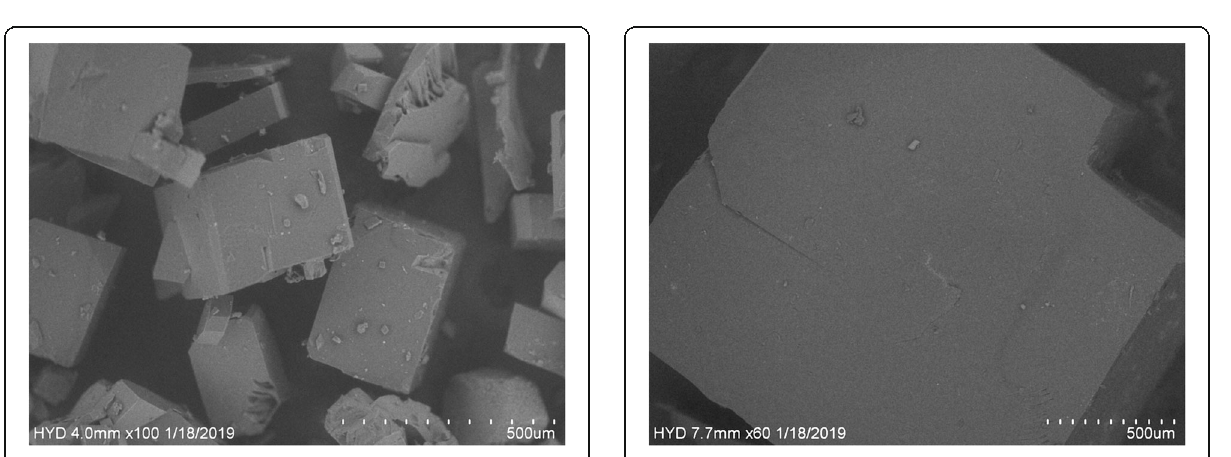
Fig. 2 SEM image of 0.65 g/ml of solute in methanol obtained by solvent evaporation method carried out for 72 h with no stir (×